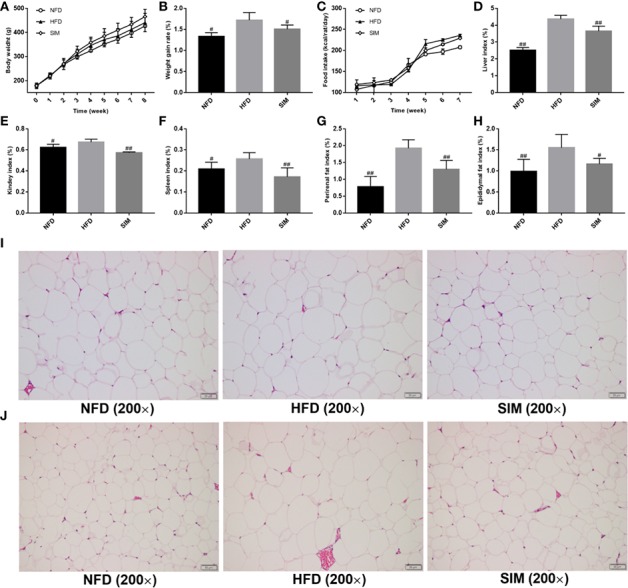
Effects of simvastatin administration on (A) body weight, (B) body weight gain rate, (C) food intakes, (D) liver index, (E) kidney index, (F) spleen index, (G) perirenal fat index, (H) epididymal fat index, (I) the size of perirenal adipocytes, and (J) the size of epididymal adipocytes in rats fed a high fat diet. #P < 0.05 as compared to the HFD group, ##P < 0.01 as compared to the HFD group.